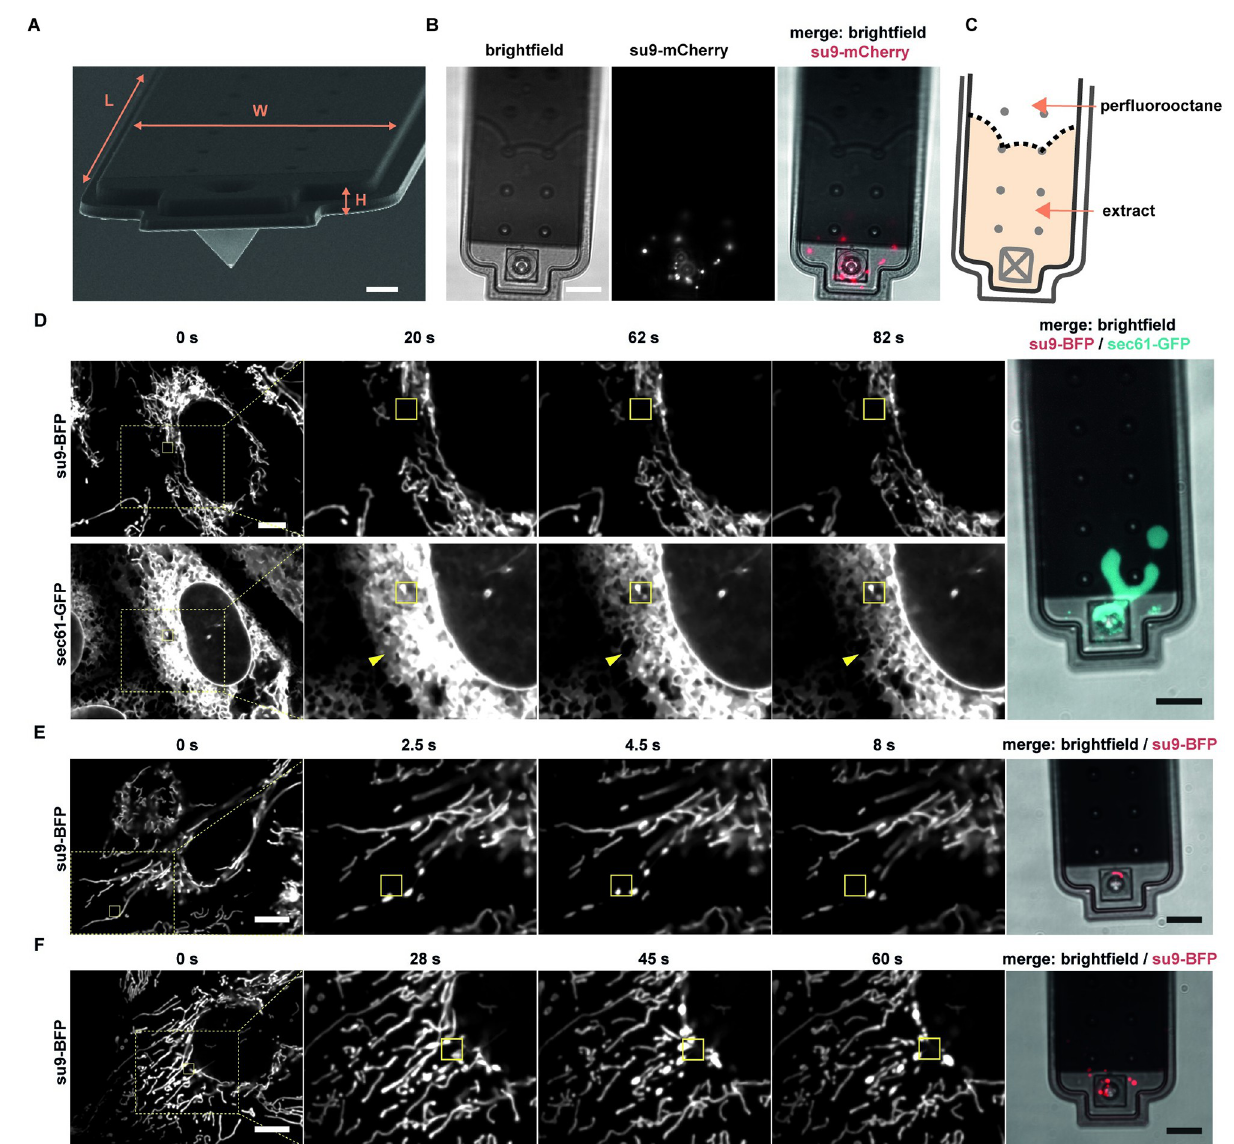
Fig 2. Organelle extraction. ( A ) Scanning electron microscopy image of a FluidFM cantilever. Channel dimensions: L = 200 μ m, W = 35 μ m, H = 1 μ m. Scale bar: 5 μ m. ( B ) Fluorescence microscopy images of a FluidFM cantilever after mitochondria extraction. The border between the extract and perfluorooctane can be seen due to different refractive indexes. Scale bar: 10 μ m. See also S1 Movie. ( C ) Scheme of the extract and perfluorooctane inside the cantilever shown in (B). The extract occupies a volume of 1170 fL. ( D - F )Time-lapse images of live cell compartment extractions and z-stacks of pyramidal cantilevers post-extraction. Yellow boxes indicate position of the cantilever apex inside the cell. (D) U2OS cell expressing su9-BFP (mitochondria) and Sec61-GFP (ER, cyan) during extraction. Arrows indicate the zone of ER retraction. A cantilever with an aperture of 0.5 μ m 2 was used. Scale bar: 10 μ m. See also S1 and S2 Movies. (E) Extraction of a single mitochondrion from a viable U2OS cell expressing su9-BFP. A cantilever with a 1 μ m 2 aperture was used. Scale bar: 10 μ m. See also S3 Movie. (F) Extraction of several mitochondria from a viable U2OS cell expressing su9-BFP. A cantilever with a 1 μ m 2 aperture was used. Scale bar: 10 μ m. See also S4 Movie. ER, endoplasmic